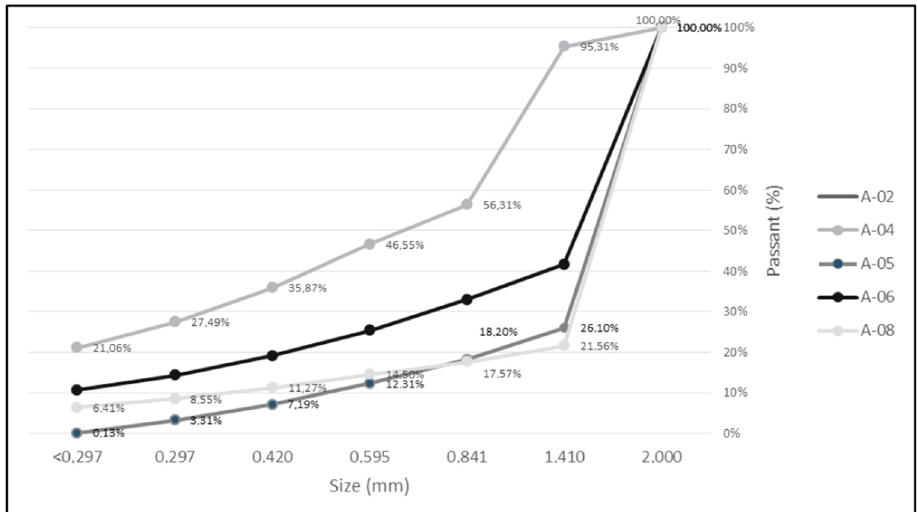
Figure 9 . Granulometric distribution (%). Figure 9. Granulometric distribution